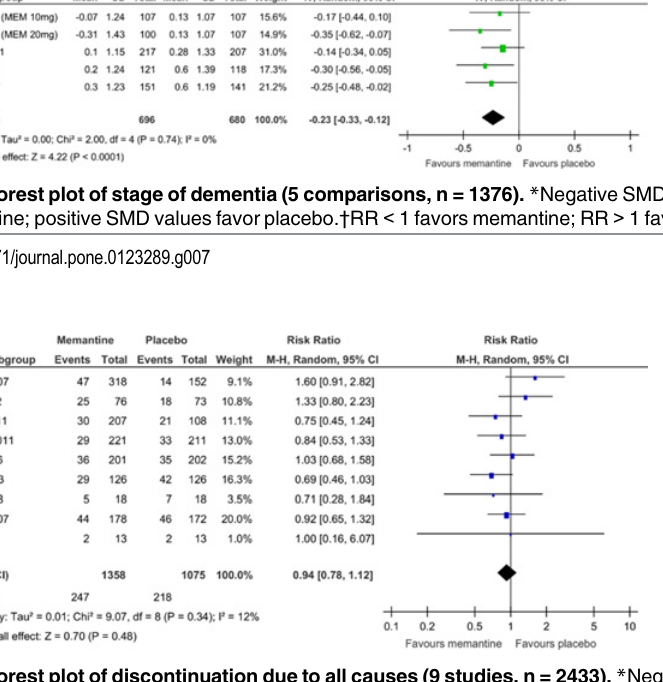
Fig 8. Forest plot of discontinuation due to all causes (9 studies, n = 2433). * Negative SMD values favor memantine; positive SMD values favor placebo. † RR < 1 favors memantine; RR > 1 favors placebo.